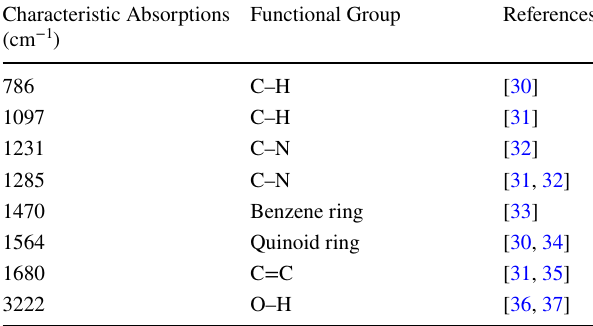
Table 1 Characteristic AT-FTIR absorption frequencies of organic functional groups of PANI/2.5 wt% GNS coated fabric Characteristic Absorptions (cm −1